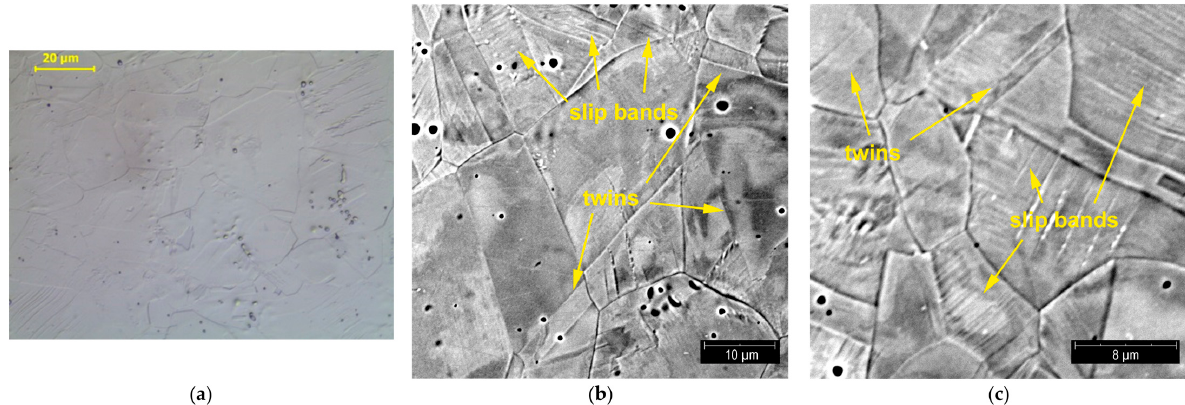
Figure 18. Structure of X2CrNi18-9 steel after 10% plastic deformation; LM ( a ) and SEM ( b,c ) observations.